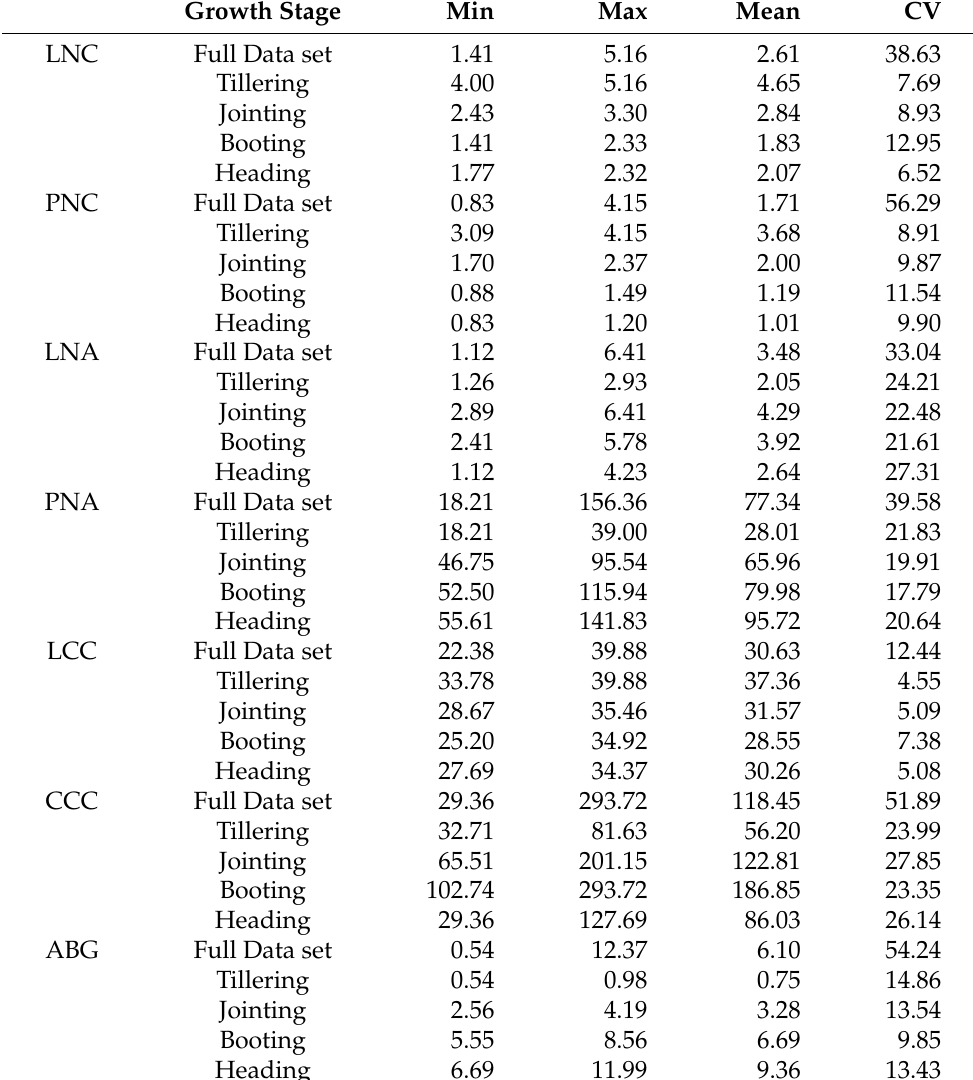
Table 2. Statistics of the observed LNC, %; PNC, %; LNA, g m − 2 ; PNA, kg ha − 1 ; LCC, µ g cm − 2 ; CCC, µ g cm − 2 and ABG, t ha − 1 . CV stands for the coefficient of variation.